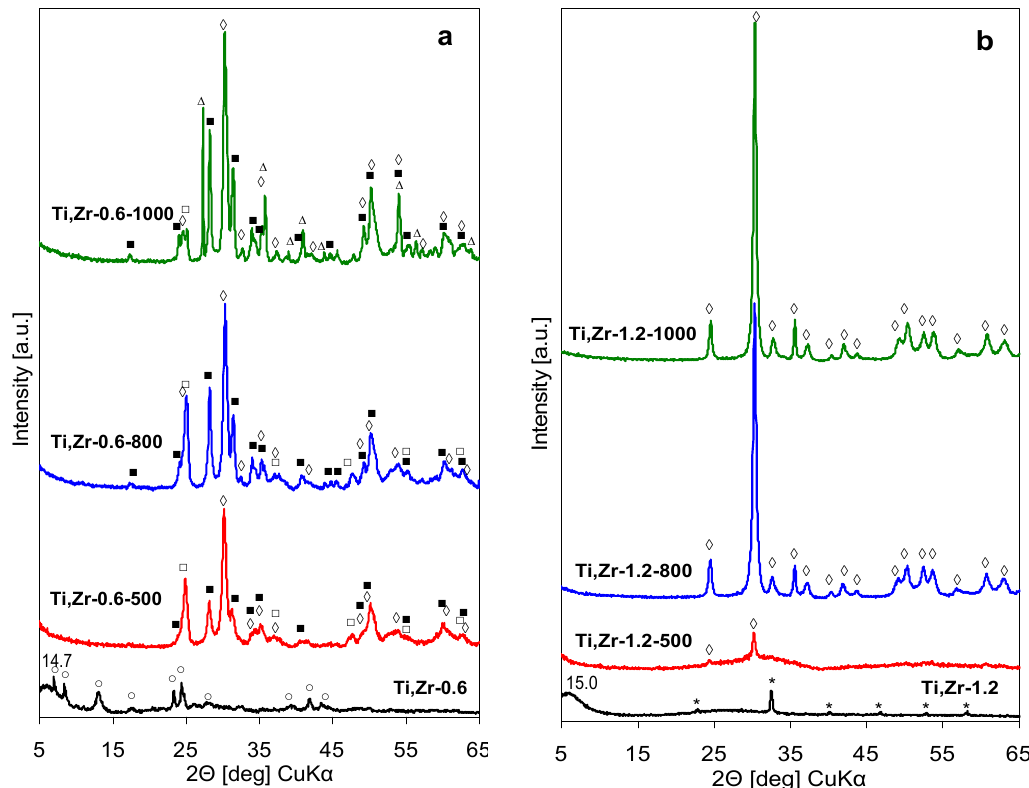
Figure 6. XRD patterns illustrating the effect of thermal treatment on hydrolysates obtained by lyophilization of Ti, Zr- pillaring solution: ( a ) As received at pH = 0.6, ( b ) after pH adjustment to 1.2 ( ○ ZrOCl 2 ∙ xH 2 O, ■ m -ZrO 2 , □ anatase, ◊ TiZrO 4 , ∆ rutile, * NH 4 Cl). The XRD pattern of lyophilized Ti, Zr-0.6 precipitate shows a set of reflexes pointing to the